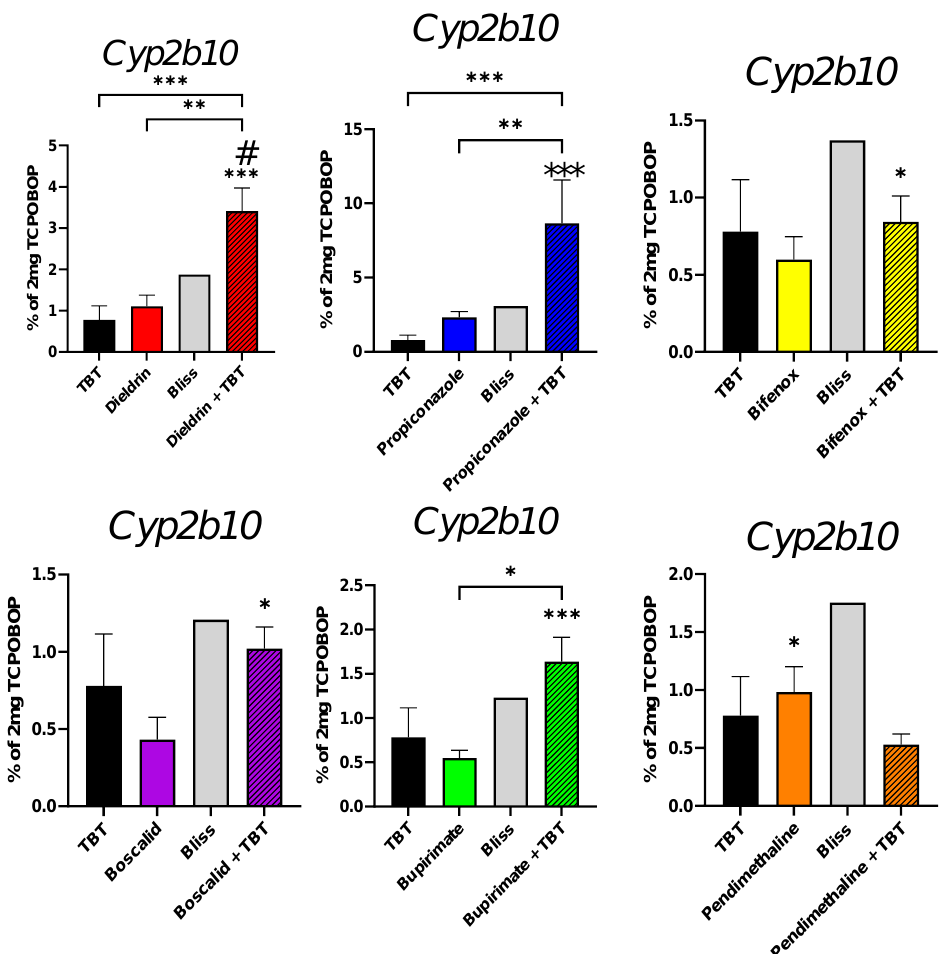
Figure 2. Gene expression levels of the CAR prototypical target gene, Cyp2b10 , in the livers of mice according to RT-qPCR. The results are presented as a graph showing the expression levels in % of the 2 mg TCPOBOP (100%) and DMSO groups (0%). The data are presented as mean ± standard error of the means. The statistical analysis used a one-way ANOVA test followed by Tukey’s multiple comparisons test to determine the difference between the pesticide-treated mice and DMSO-treated mice. The p -values indicate the level of significance, with * p < 0.05, ** p < 0.01, and *** p < 0.001 indicating significant differences. Additionally, the study also used a one-sample t -test to determine the difference between the observed effect of TBT + pesticide and the calculated Bliss additivity of TBT + pesticide, represented by # p < 0.05.